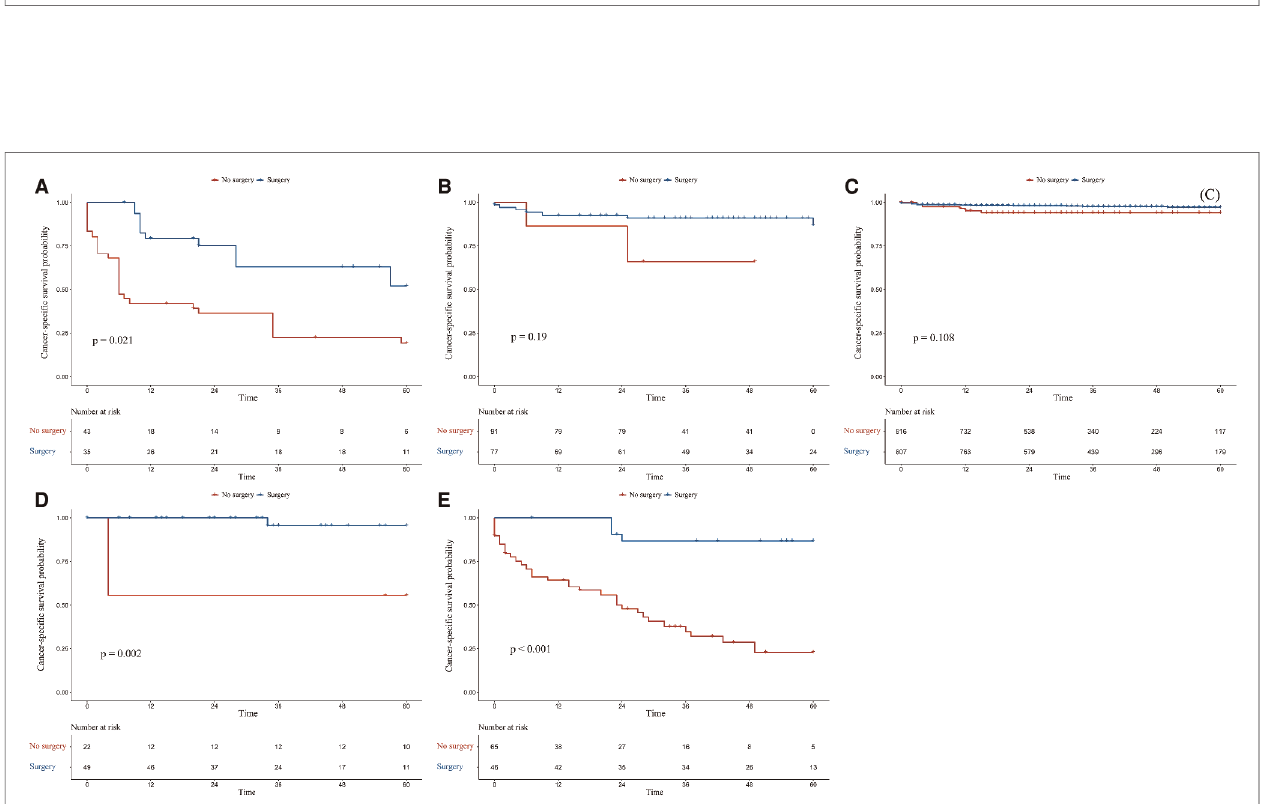
FIGURE 3 | Kaplan – Meier survival estimates of overall survival in different subgroups after inverse probability of treatment weighting adjustment: ( A ) G1, ( B ) M0N1G0, ( C ) M0N0G0, ( D ) M0N0G0E1, and ( E ) M1N0G0.